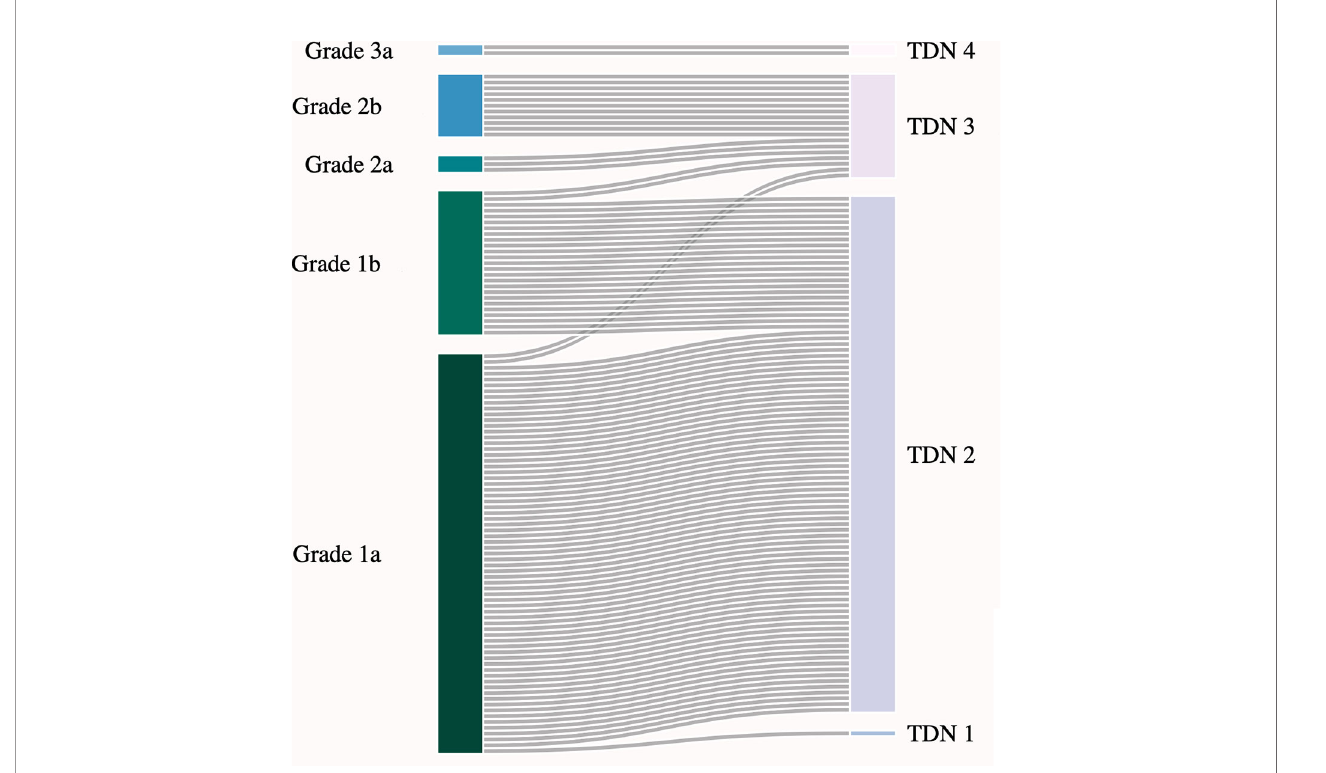
FIGURE 3 | Comparison between LIC grade and TDN score ( N =